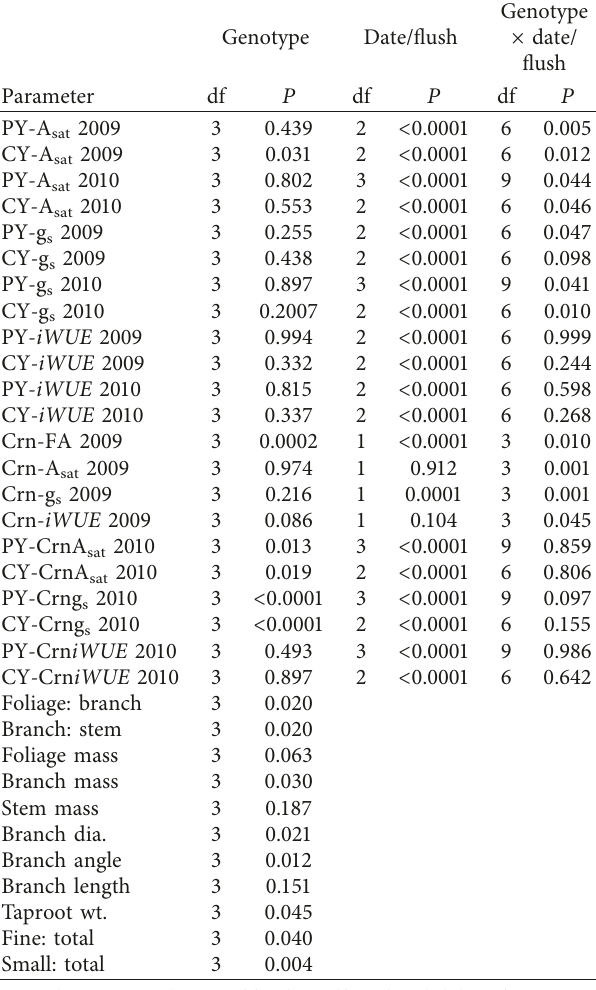
Table 1: Tests of fixed effects of leaf-level and crown-level (Crn) photosynthetic capacity ( A sat ), conductance ( g s ), and intrinsic use efficiency ( iWUE ) in previous-year (PY) and current-year (CY) foliage flushes as well as foliage area (FA) and biomass partitioning parameters (foliage :branch mass, branch :stem mass, foliage mass, branch mass, stem mass, branch diameter, branch length, branch angle, taproot weight, fine: total root mass, and small :total root mass) of four loblolly pine genotypes in North Central Louisiana,